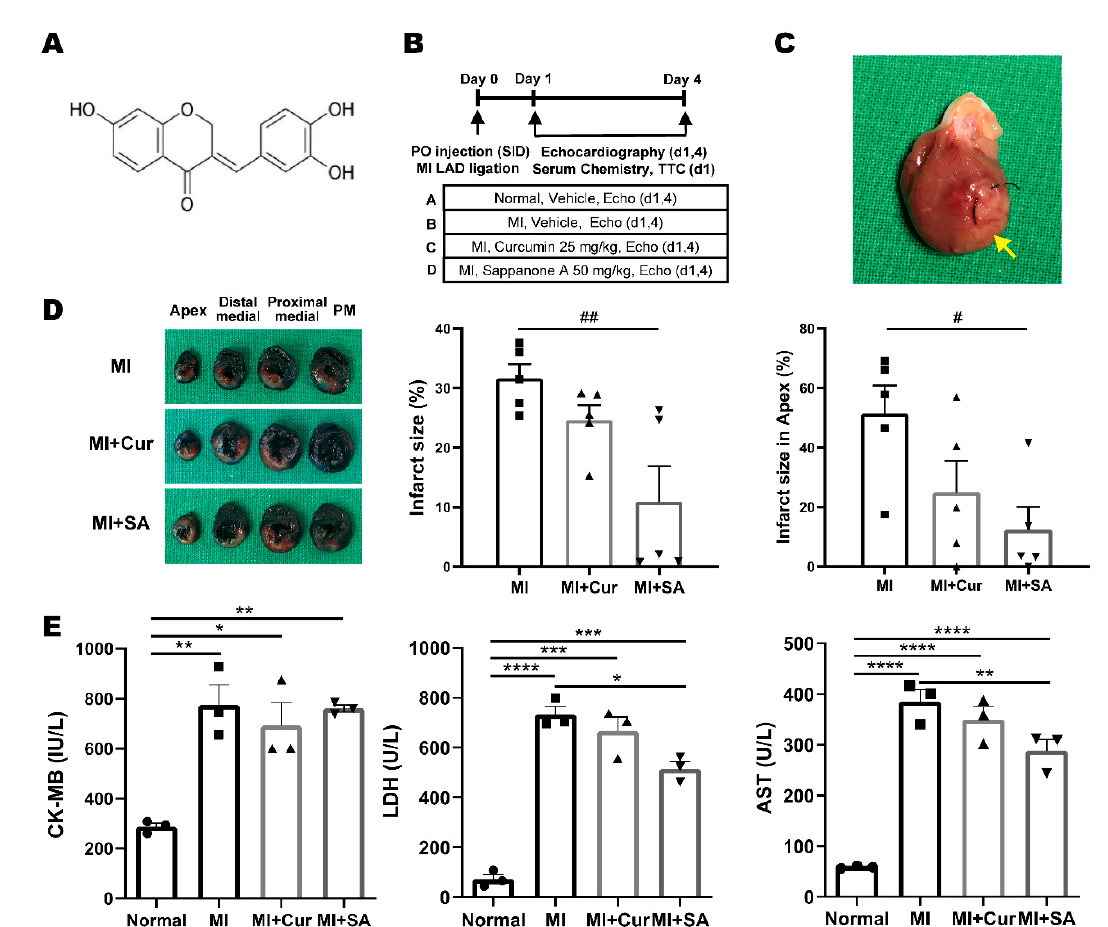
Figure 1. The experimental design and the positive effect on the infarct size and serum cardiac marker. ( A ) Chemical structure of sappanone A. ( B ) The animals were divided into four groups: Group A, Normal control; Group B, MI + Vehicle; Group C, MI+Curcumin 25 mg/kg; Group D, MI+Sappanone A 50 mg/kg. ( C ) Representative gross photograph of a heart on day 1 after MI surgery and the infarct area (yellow arrow). ( D ) Representative photographs of left ventricle slices of the groups and the infarct size of the left ventricles of the total and apex areas in each group ( n = 5/group, right). # p < 0.05 and ## p < 0.01 by one-way ANOVA test with Tukey’s post hoc correction. ( E ) Serum chemistry results of creatine kinase MB isozyme (CK-MB, n = 3/group), lactate dehydrogenase (LDH, n = 3/group), and aspartate aminotransferase (AST, n = 3/group) on day 1 after MI surgery. ** p < 0.01, *** p < 0.001, **** p < 0.0001 by two-way ANOVA test with Tukey’s post hoc correction.